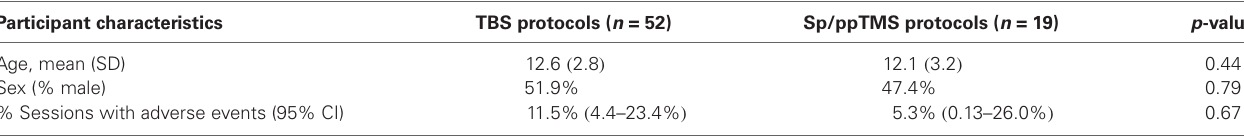
Table 3 | Healthy control participant characteristics and adverse events . Participant